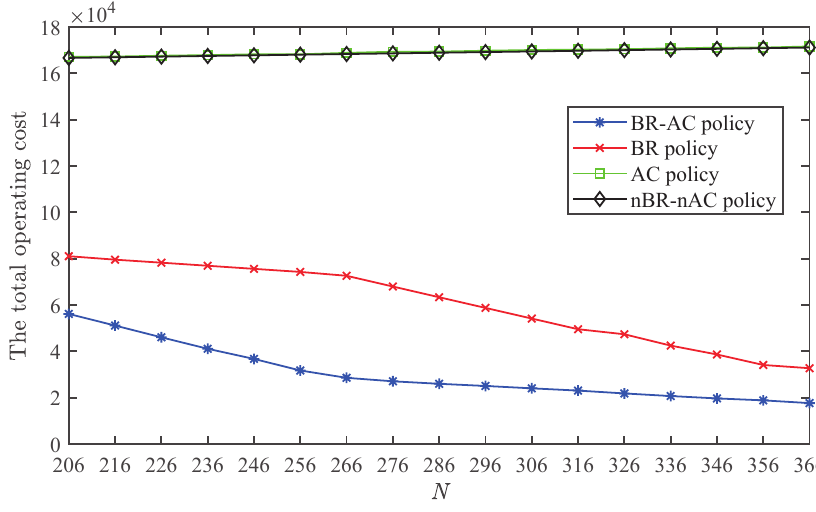
Figure 18. The total operating cost under four different